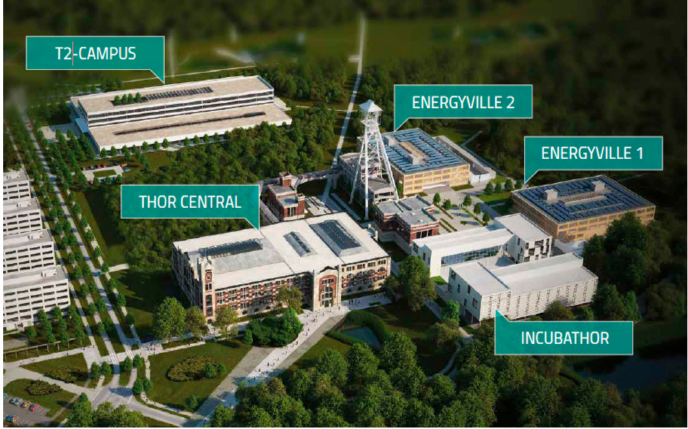
Figure 7. Diagram for the campus Thor Lab provided by EnergyVille